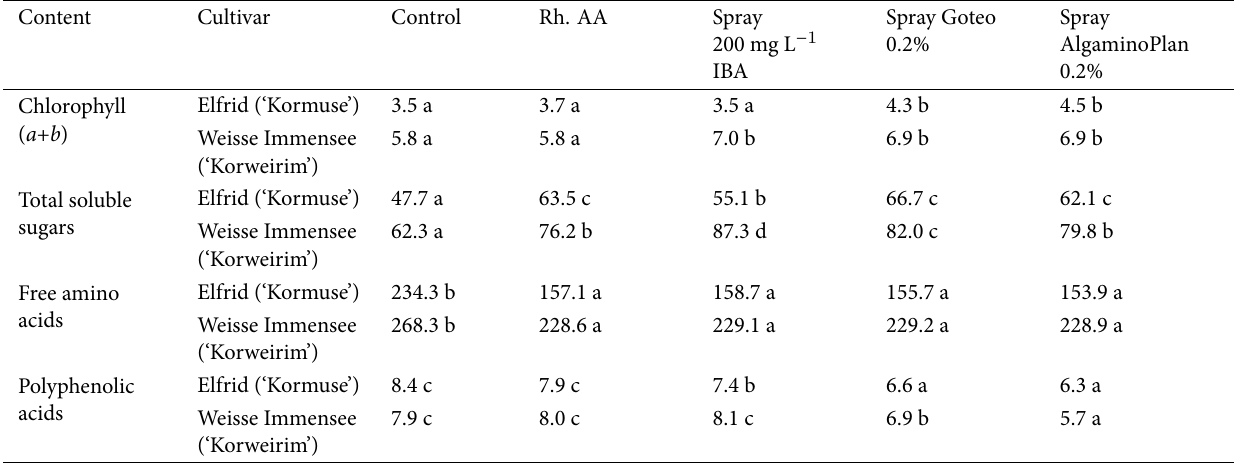
Table 5 The effects of IB, Goteo, and AlgaminoPlant on the chlorophyll ( a + b ) (mg g DW), free amino acid ( µ mol g Weisse Immensee